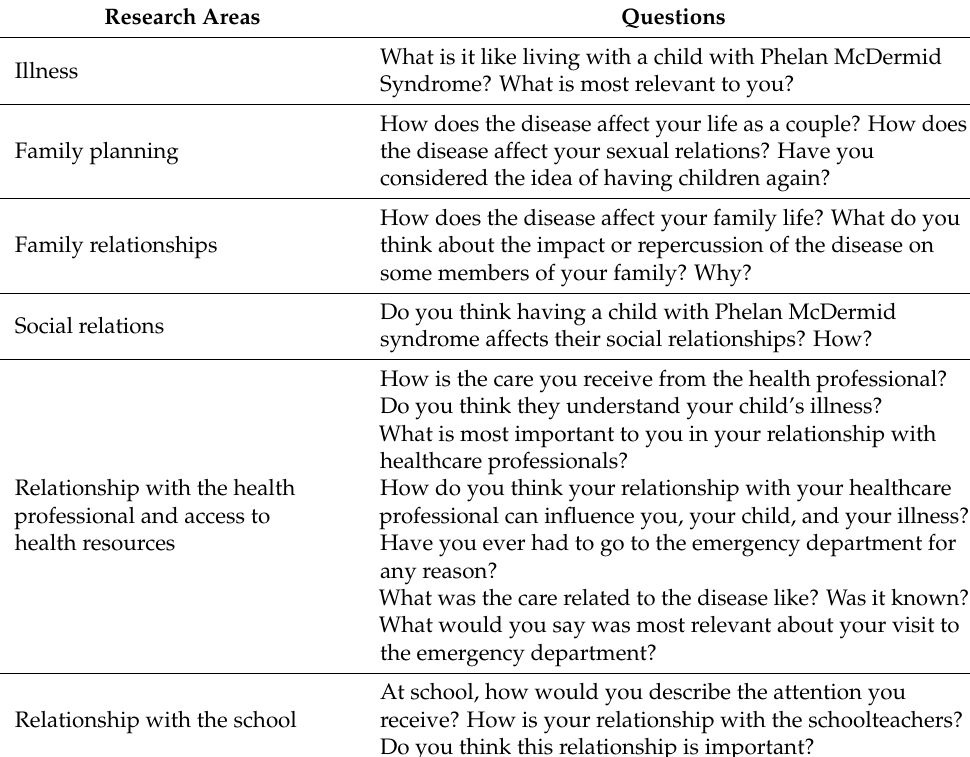
Table 1. Semi-structured question